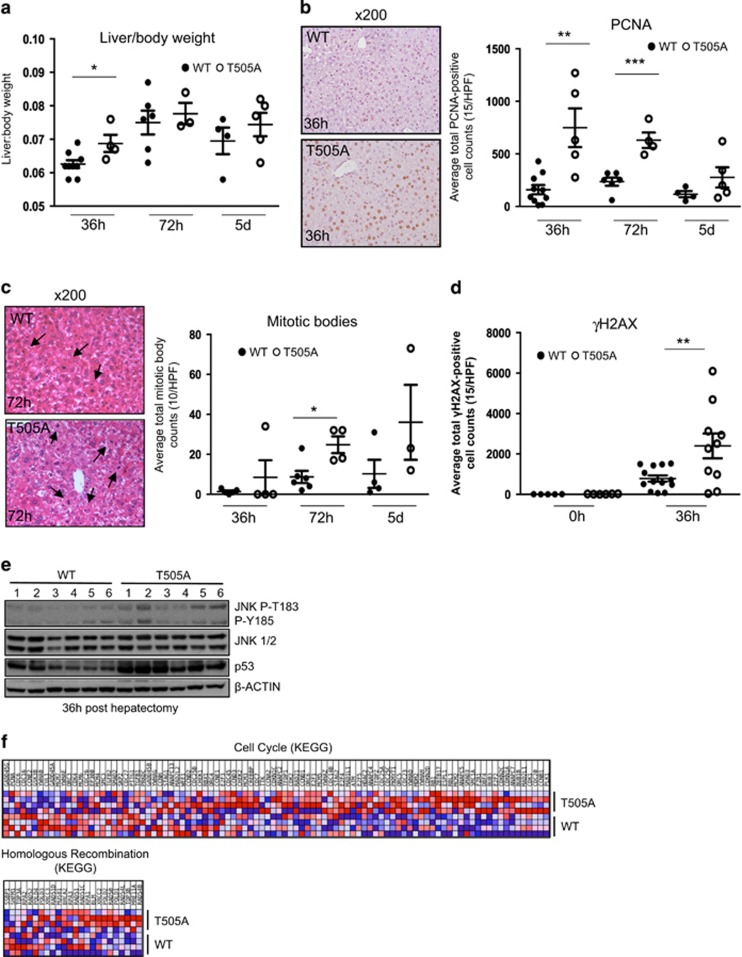
Increased hepatocyte proliferation in RelA T505A mice following partial hepatectomy. (a) Liver:body weight ratio at 36 h, 72 h and 5 days post partial hepatectomy (PhX) surgery in male WT and T505A mice. WT n=6; T505A n=6 per time point. (b–d) Mean number of cells/100 × field scoring positive for PCNA (b), mitotic bodies (c) and γH2AX (d) in WT and T505A liver tissue sections following PhX surgery. Representative images of each are shown. Photomicrographs are at × 200 magnification. *P<0.05, **P<0.01, ***P<0.001 (Unpaired Student's t-test). (e) Western blots with antibodies against total or phospho-JNK Thr183/Tyr185 and p53 in 36 h PhX liver samples from six WT and six T505A male mice. (f) GSEA of microarray data from livers of WT and RelA T505A mice 36 h following partial hepatectomy. Shown are the heat map results for KEGG-defined pathways for genes regulating cell cycle (KEGG_CELL_CYCLE, Enrichment Score −0.5287153; Normalised Enrichment Score −1.896711; Nominal P-value 0.0; false discovery rate q-value 0.004132211; familywise error rate P-value 0.014 and homologous recombination (KEGG _HOMOLOGOUS_RECOMBINATION; Enrichment Score −0.6658461; Normalised Enrichment Score −1.8532548; Nominal P-value 0.0; false discovery rate q-value 0.0063102846; Familywise error rate P-value 0.029). The heat map shows the clustered genes in the leading edge subsets of the gene set concerned (i.e., those showing the most differential expression between the data sets). The colours correspond to expression values, where red, pink, light blue and dark blue show the range of expression values from high to moderate to low to lowest, respectively.